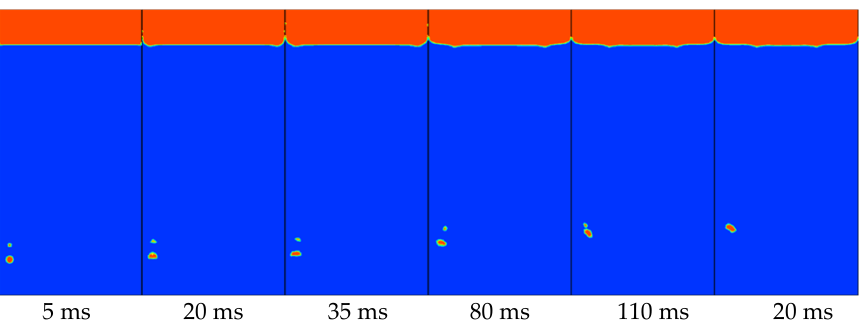
Figure 13. The rising shape of double bubbles of different sizes near the wall (upper small and lower large).